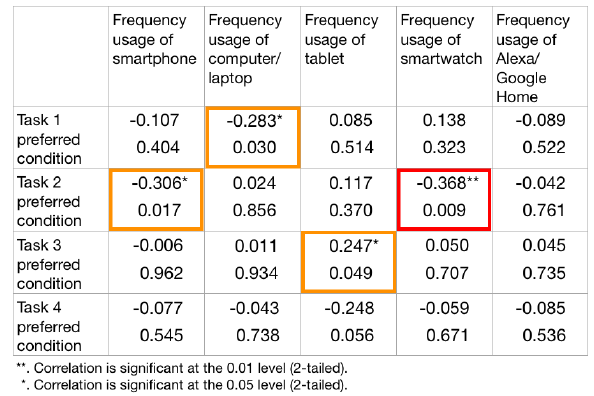
Figure 24: Correlation table between the usage frequency of tech- nology and participants’ preferred